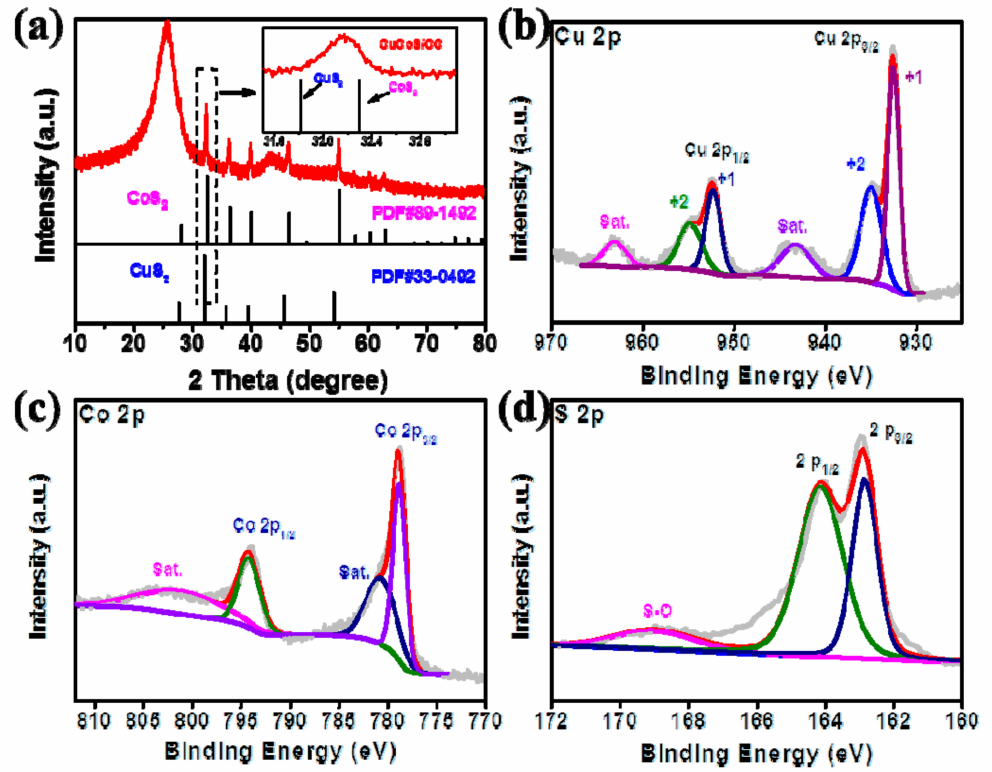
Figure 2. ( a ) X-ray di ff raction (XRD) pattern of CuCoS / CC. High-resolution X-ray photoelectron spectroscopy (XPS) spectra of ( b ) Cu 2p and ( c ) Co 2p ( d ) S 2p regions of CuCoS /